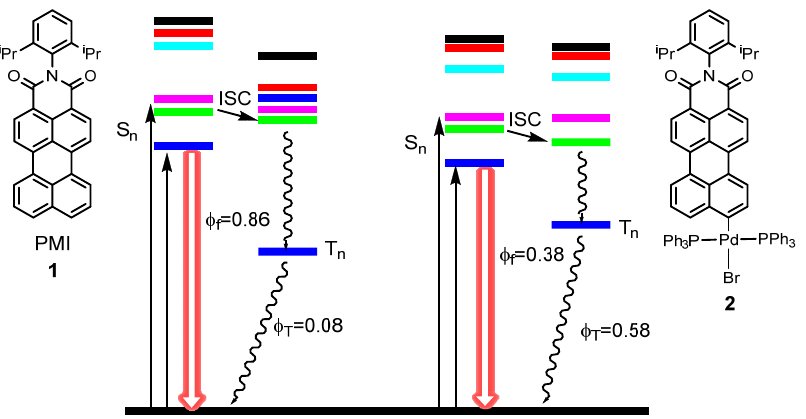
Figure 2. Jablonski diagram depicting the energy levels and the photophysics of PMI 1 and PMI-Pd 2 . Adapted from [59].